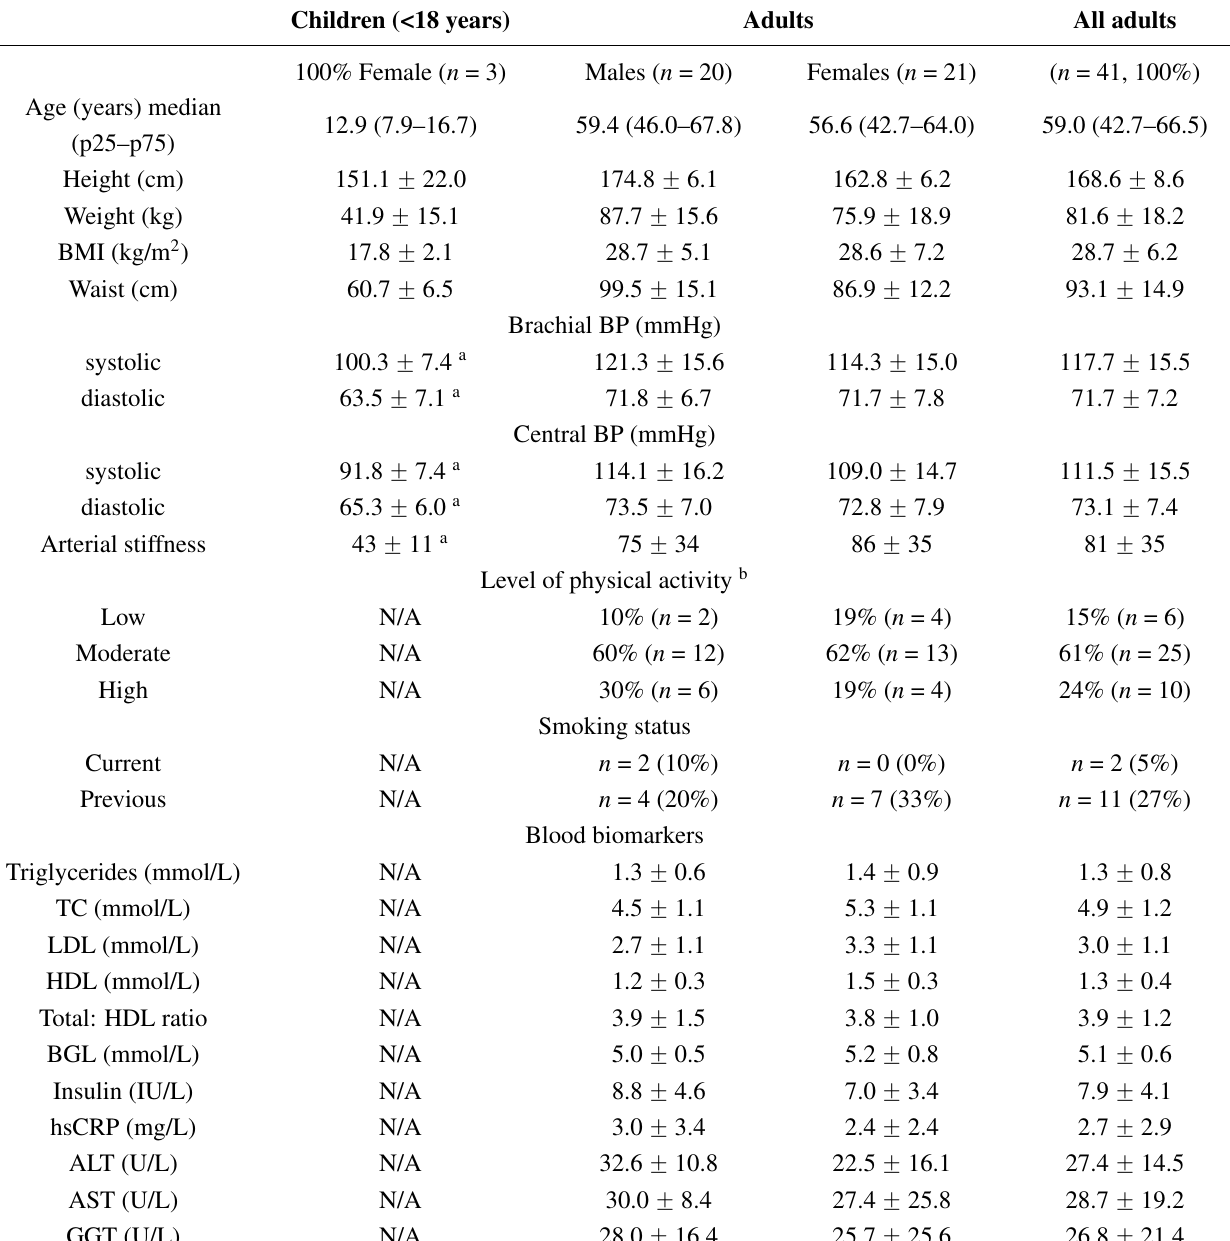
Table 1. Baseline characteristics of the Love your food, Love your heart, Love your family study participants, inclusive of 15 families, presented as mean ˘ standard deviation, except where